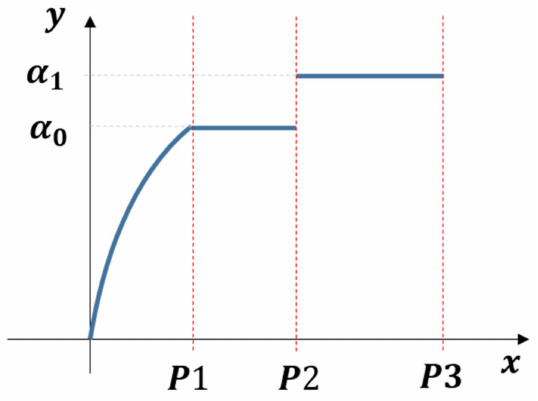
Figure 5. Average value analysis